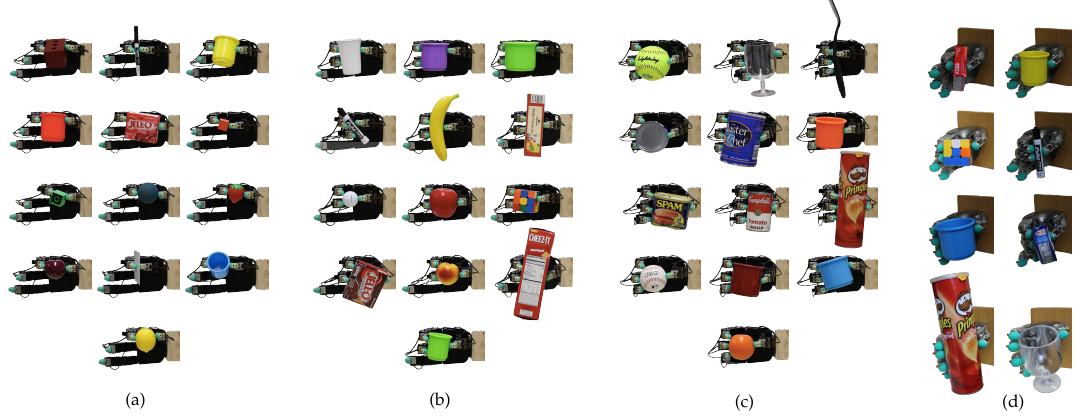
Figure 4. Stable grasps on a variety of objects. The specific grasp configurations varied from trial-to-trial but always resulted in stable grasps. The figure shows ( a ) two-finger, ( b ) three-finger and ( c ) four-finger grasps with the Allegro Hand and ( d ) two-finger, three-finger, four-finger and five-finger grasps with the Wessling Robotic Hand respectively from the first to the bottom lines.